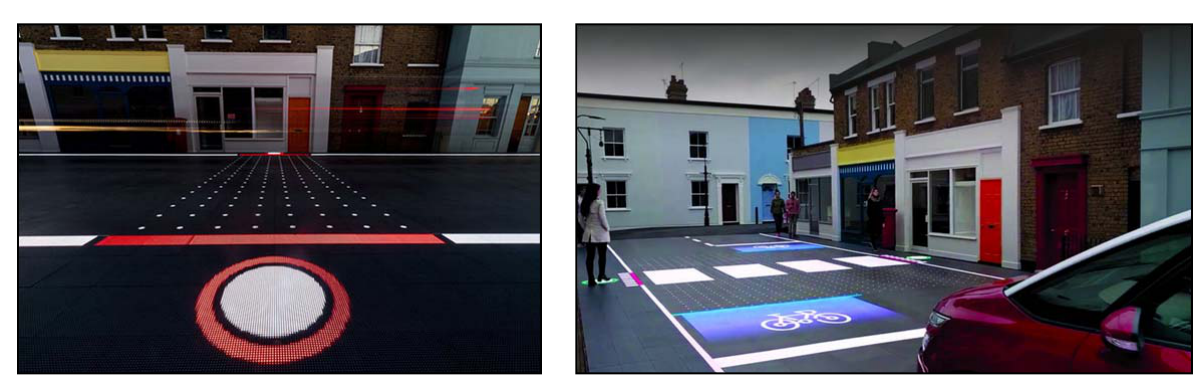
Figure 8. Crossing for intelligent pedestrians – The Starling